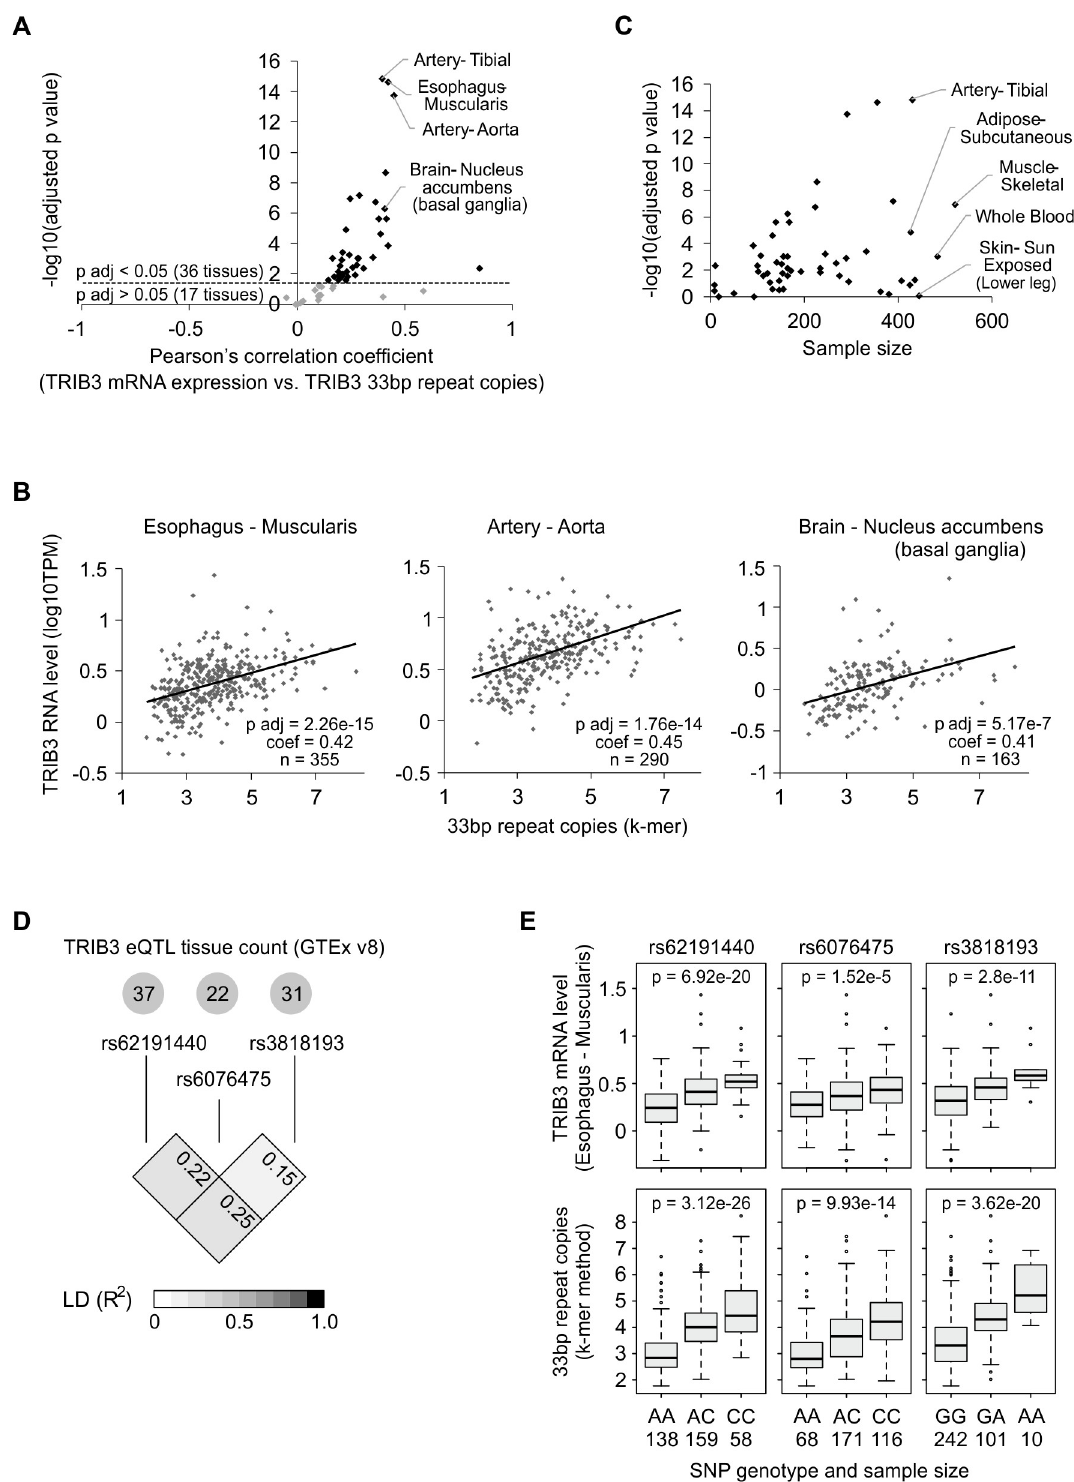
Fig 5. Variation in the TRIB3 33-bp repeat copy number is linked to TRIB3 expression level in various tissues of the body. (A) Correlation between TRIB3 33-bp repeat copy number and TRIB3 gene expression level in 53 tissues from the Genotype-Tissue Expression (GTEx) v8 data set. The analysis included all tissues with � 5 donors with RNA-Seq and whole genome sequencing from the same donor. The k-mer counting method was used to estimate the TRIB3 33-bp repeat copy number from genome